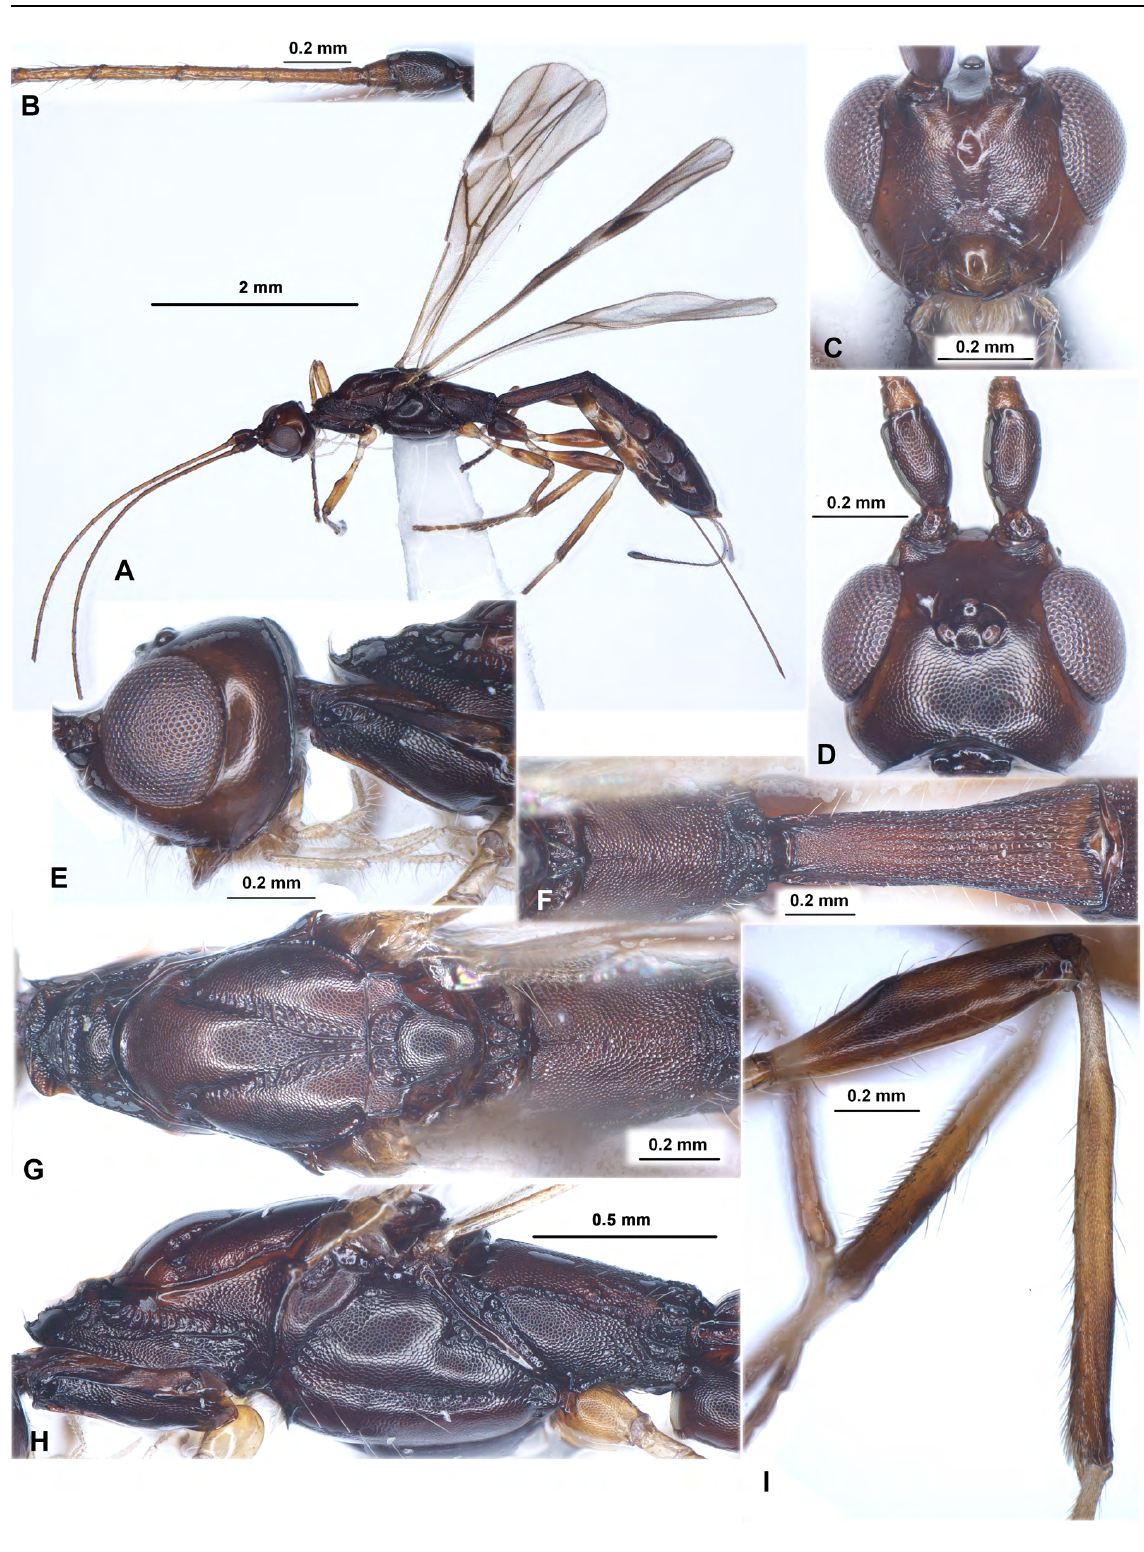
Fig. 34. Platyspathius ( Platyspathius ) ranomafanus sp. nov., ♀, holotype, ZISP. A . Habitus, lateral view. B . Basal segments of antenna. C . Head, front view. D . Head, dorsal view. E . Head, lateral view. F . Propodeum and first metasomal tergite, dorsal view. G . Mesosoma, dorsal view. H . Mesosoma, lateral view. I . Hind femur and tibia, lateral